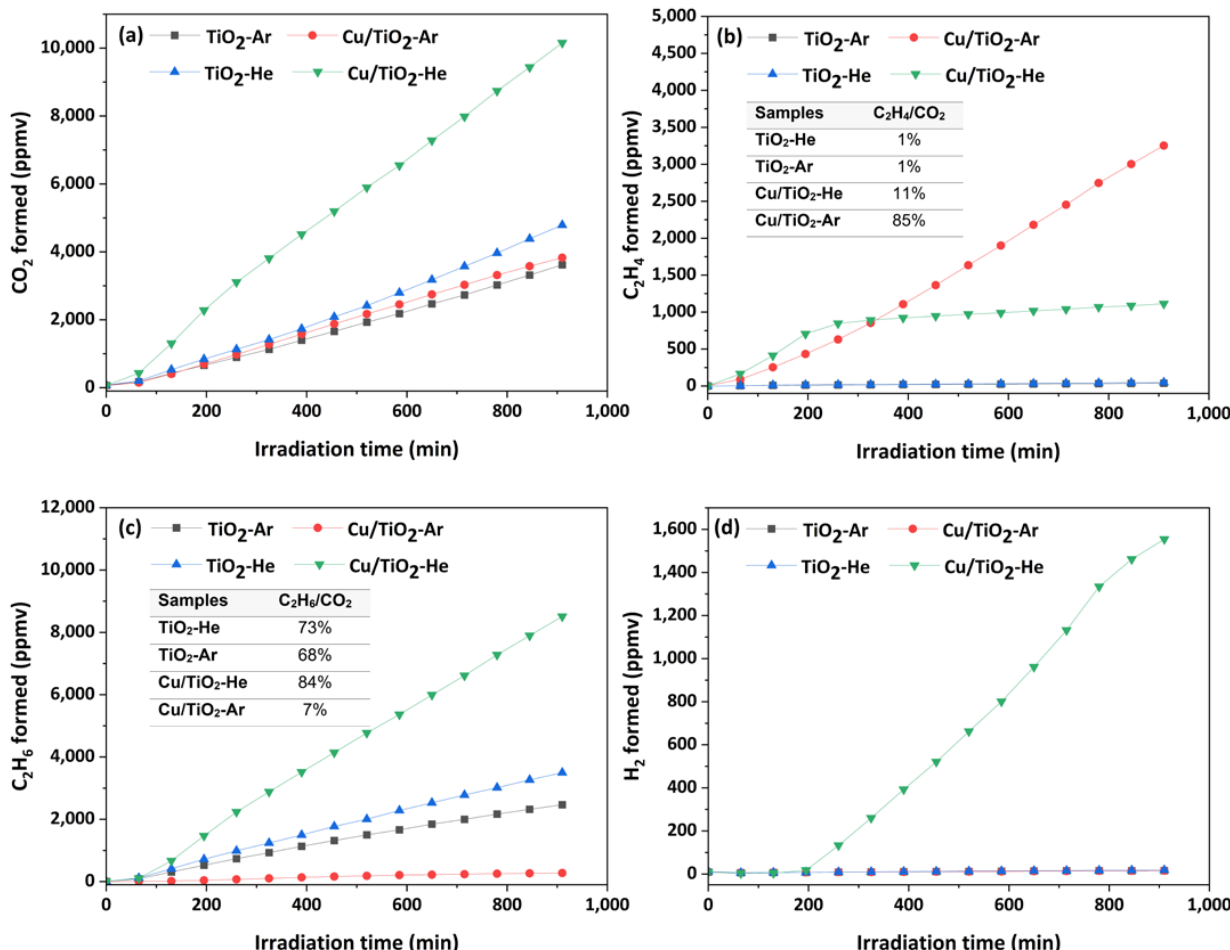
Figure 4. Major products formed from the photo-decarboxylation of PA (1 vol%) under UVA light: CO 2 ( a ), C 2 H 4 ( b ), C 2 H 6 ( c ), H 2 ( d ). Ratios are calculated at 910 min of irradiation (see also Figure S11).